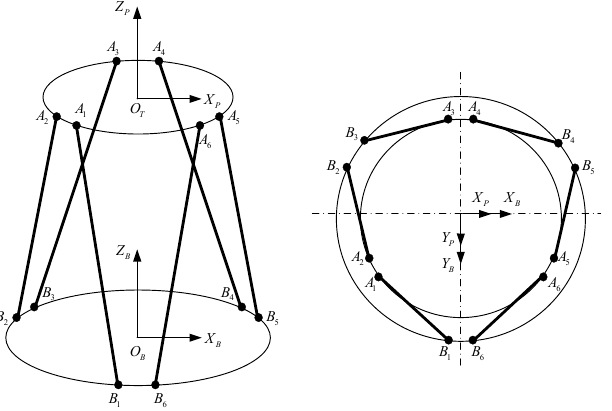
Figure 6. Simplified mathematical model of Stewart parallel mechanism.